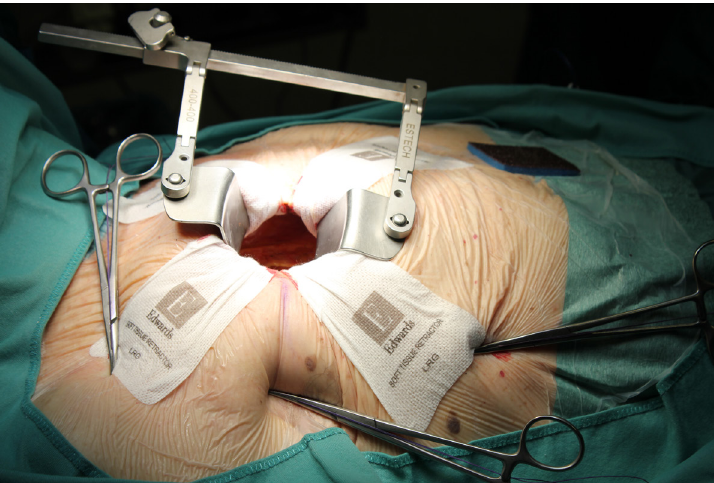
Fig. 4 - Aortic cannulation: handier than it may